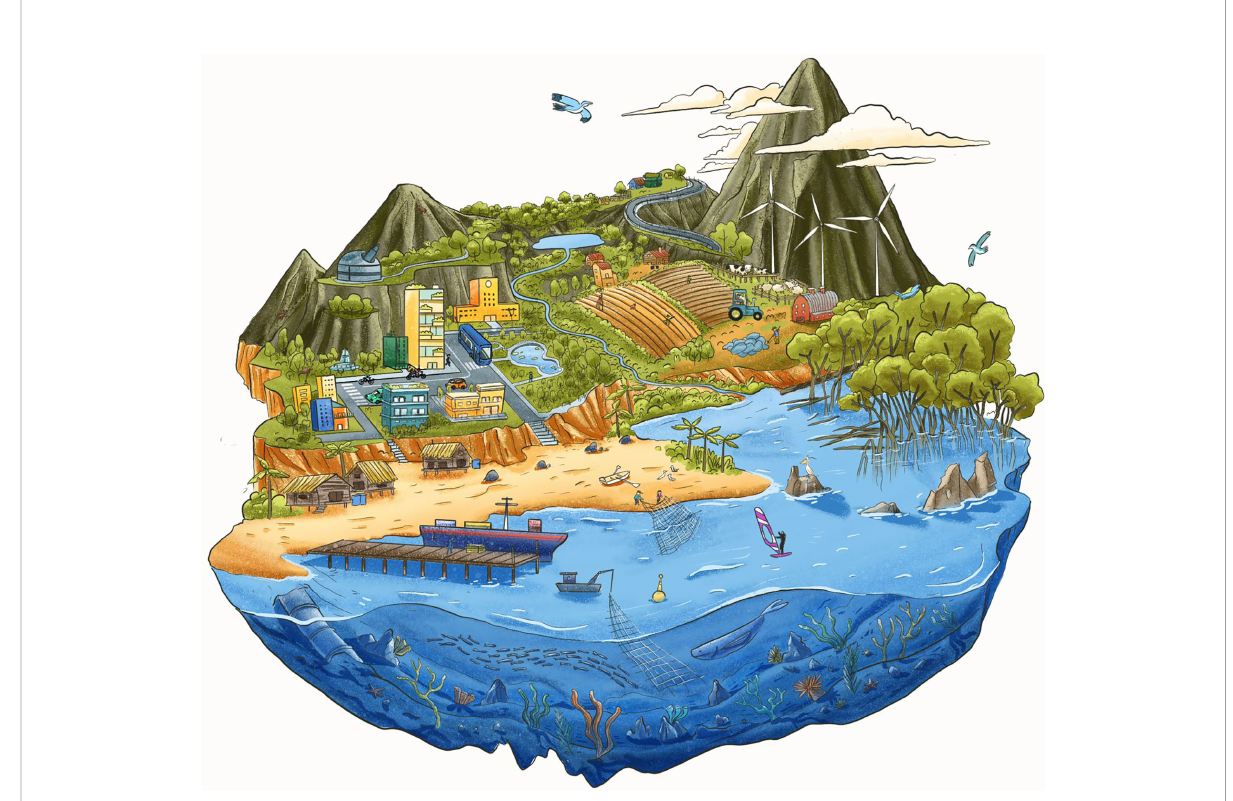
FIGURE 1 Stylized depiction of integrated conservation in interconnected working landscapes and seascapes. The image shows how working landscapes and seascapes are mosaics of natural areas, managed ecosystems, communities, uses, and infrastructures that provide ecosystem services (e.g., food, water, fi ber, and fuel) and support human activities. Conservation in working landscapes and seascapes is characterized by holistic management, integrative thinking, multiple conservation actions, sustainable uses, inclusive processes and coordinated governance, in order to effectively maintain and/or restore biodiversity and ecosystem services as the foundation of livelihoods and human well-being. (Credit: Max Jake Palomino - Instagram